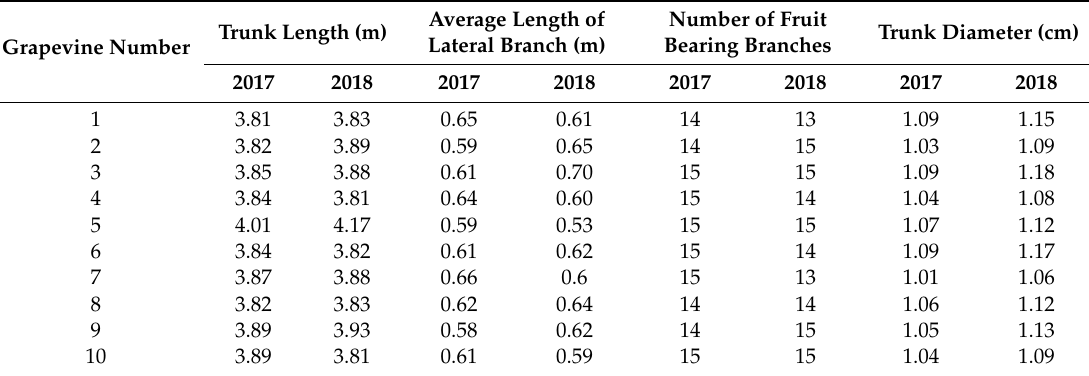
Table 1. Characteristics of grapevines selected for sap flow